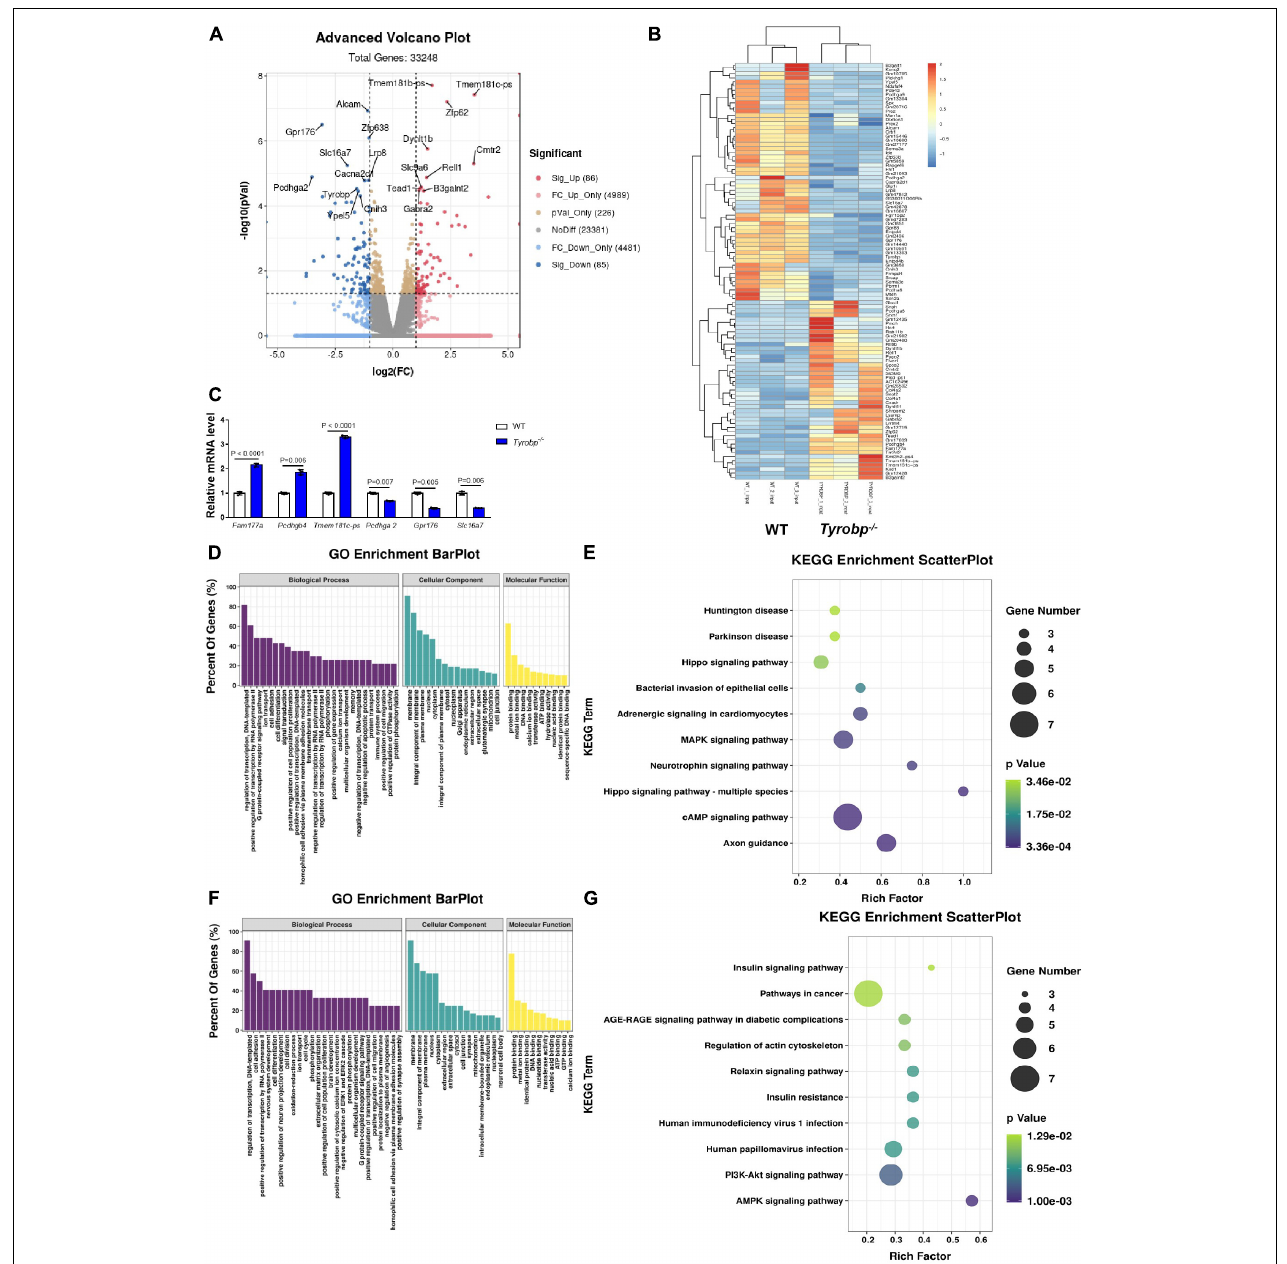
FIGURE 7 | Volcano plots, heatmaps, Gene Ontology (GO) terms and Kyoto Encyclopedia of Genes and Genomes (KEGG) pathways enriched in genes differentially expressed between wild-type (WT) and Tyrobp − / − mice. (A) Volcano plots and (B) heatmap showing genes and transcripts differentially expressed between WT and Tyrobp − / − mice. (C) Quantitative real-time PCR detection of six genes chosen from the methylated RNA immunoprecipitation sequencing data. (D,E) Major GO terms and KEGG pathways were analyzed for genes upregulated by Tyrobp knockout. (F,G) Major GO terms and KEGG pathways were analyzed for genes downregulated by Tyrobp knockout. Up- or downregulation was defined, respectively, as fold change ≥ 2 or fold change ≤ –2 combined with P < 0.05. Nine mice were used in each